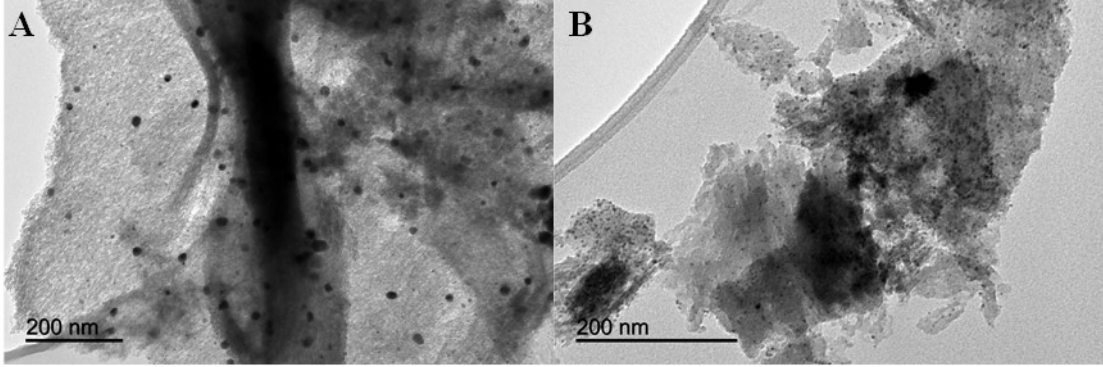
Figure 3. TEM images of the Pd-N/C a ( A ) and Pd-N/C b ( B ) samples.